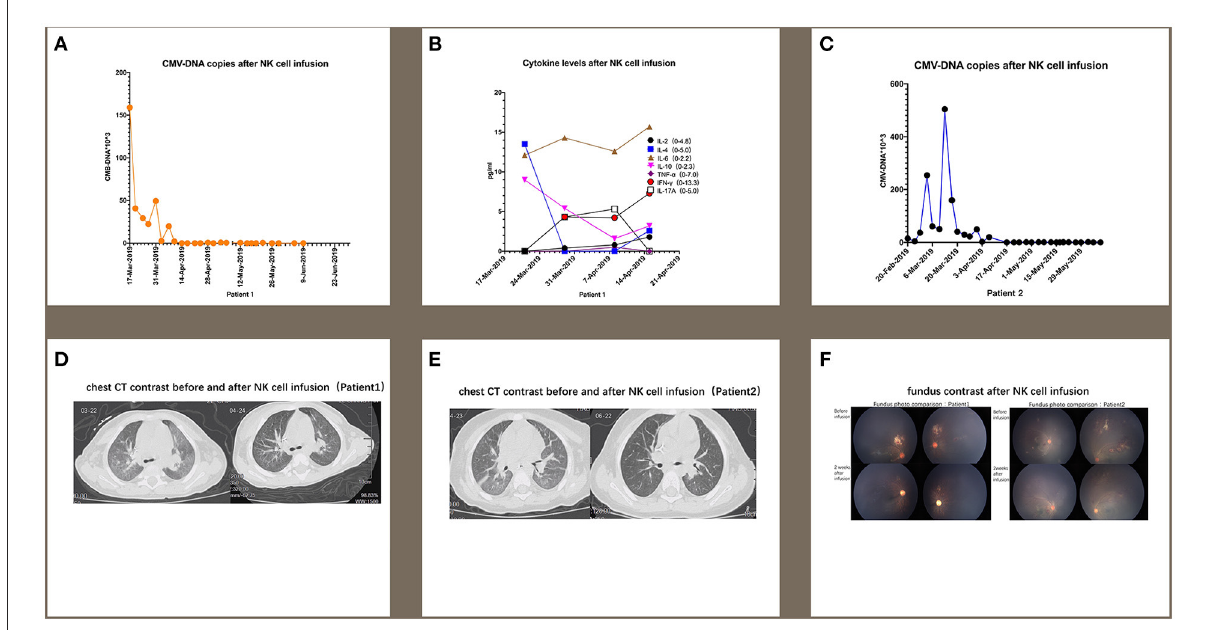
FIGURE1 For patient 1, the number of CMV DNA copies (A) changes in cytokine levels (B) , and chest computed tomography (CT) obtained before and after cell infusion (D) are presented in this figure. For patient 2, the changes in CMV DNA copy number (C) and chest CT (E) after NK cell infusion are also presented. (F) indicates that CMV infection-related retinitis improved after NK cell infusion in both patients. NK cells were expanded directly from peripheral blood mononuclear cells (PBMCs) collected from two haploidentical donors, and cultured for 3 weeks by